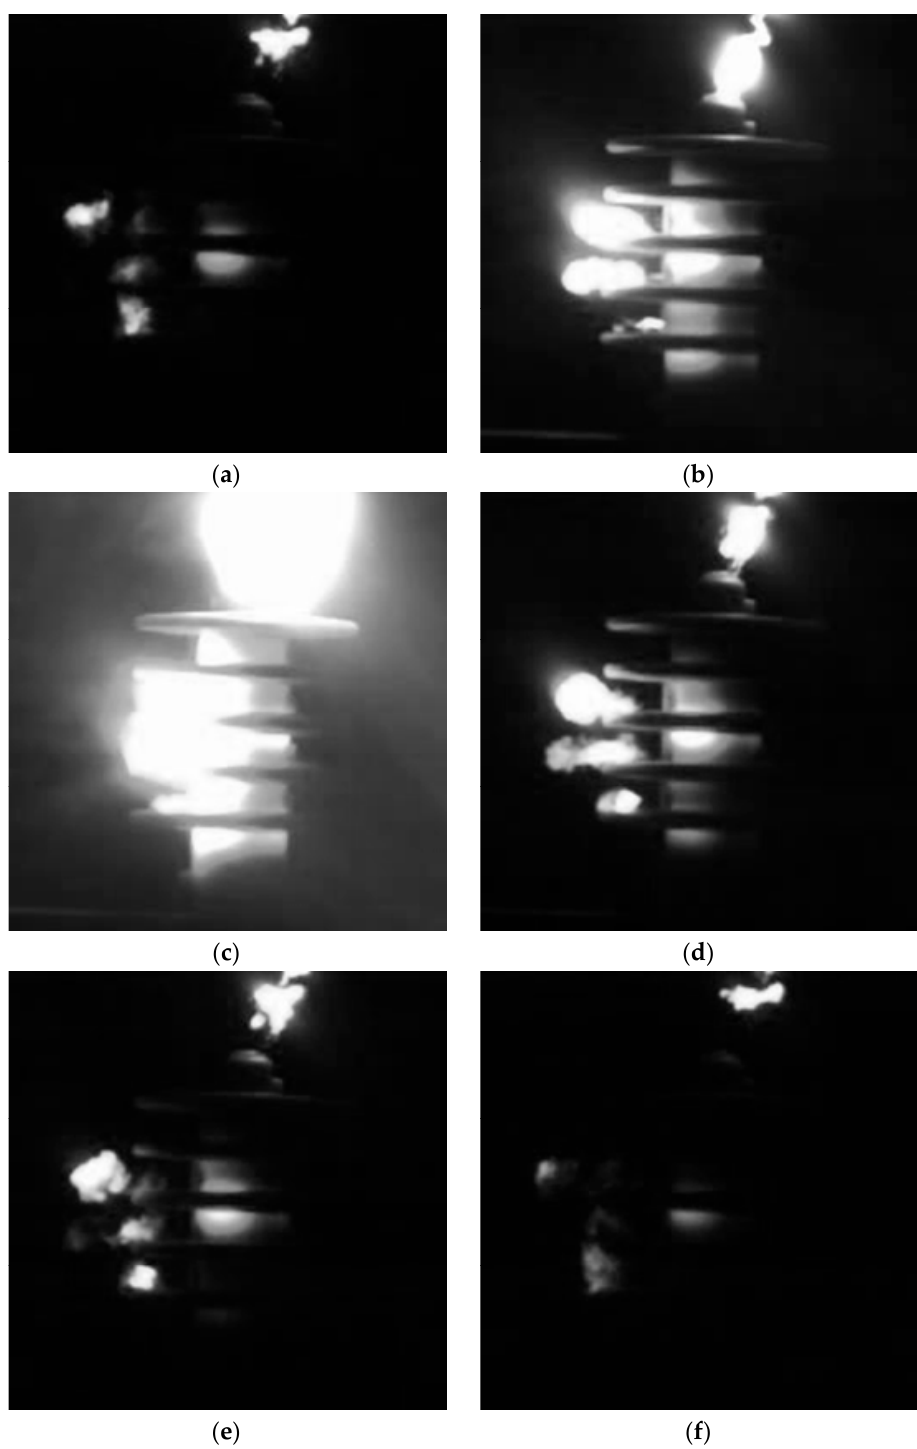
Figure 8. Action diagram of the air blowing arc extinguishing gap. ( a ) The air gap was broken through and an arc channel was formed; ( b ) the air inside the tube heated up rapidly and the airflow started to form a trend towards the nozzle; ( c ) the air in the gap formed a high temperature energy body, at this time the most violent action; ( d ) the arc and the air medium between the radiation, convection, and other heat exchange processes gradually decayed the arc energy; ( e ) the trend of the air ‐ blown arc was significantly weakened; ( f ) the arc was unable to maintain stable combustion, and was gradually extinguished.